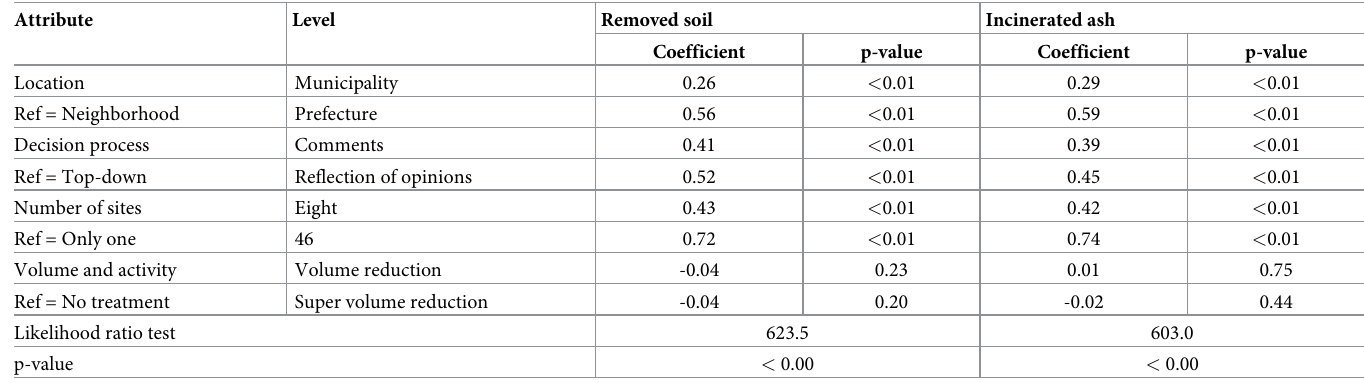
Table 4. Conjoint analysis